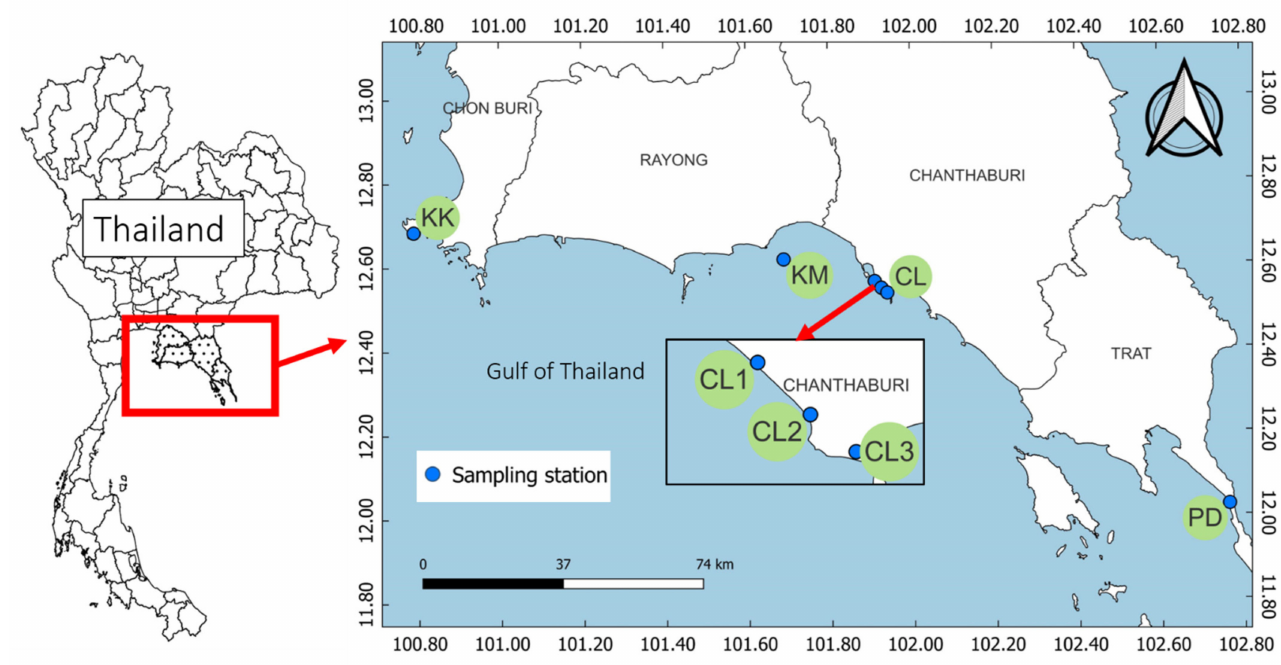
Figure 1. Map and location coordinates of the sediment sampling stations in the eastern Gulf of Thailand during March and July